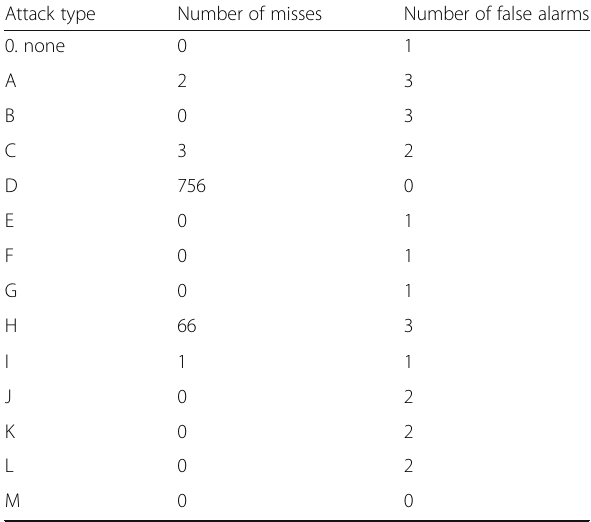
Table 3 Detection of the embedded synchronization codes under various attacks. Overall, the synchronization code has